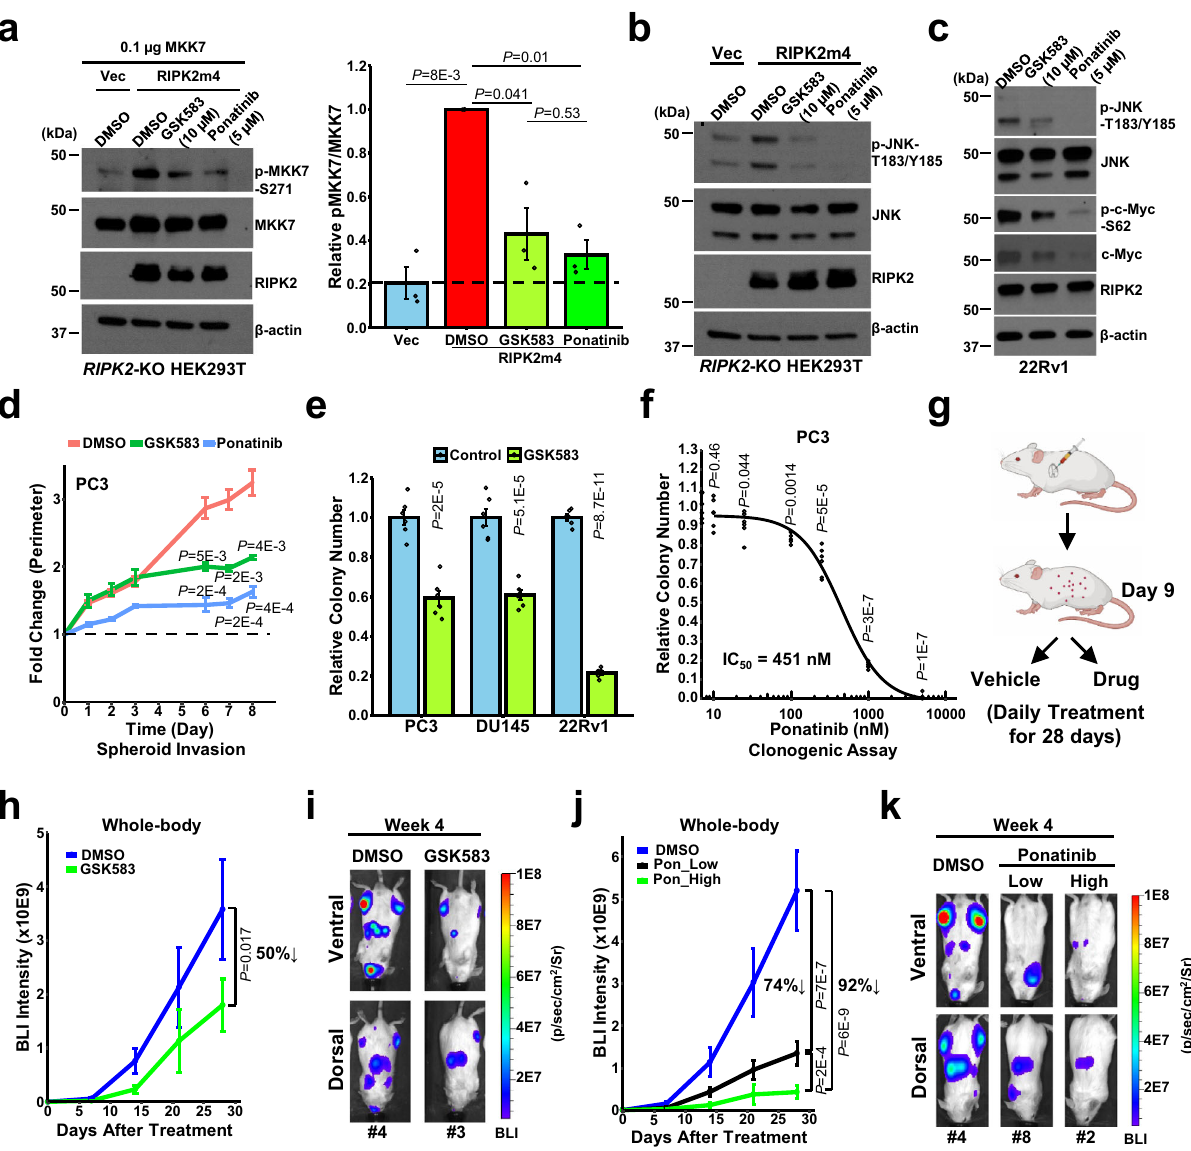
Fig. 8 Pharmacological inhibition of RIPK2 inactivates RIPK2/MKK7/c-Myc signaling and suppresses PC metastatic outgrowth. a Representative immunoblots (left) and quanti fi cation (right) of p-MKK7-S271 in total lysates of RIPK2 -KO HEK293T cells under the indicated conditions (2 h treatment in the presence of 10% FBS) ( n = 3 biologically independent samples per group). b , c Representative immunoblots of the indicated proteins in total lysates of b RIPK2 -KO HEK293T cells or c 22Rv1 cells under the indicated conditions (2 h treatment). Experiments were repeated three times independently with similar results ( b , c ). d Quanti fi cation of 3D spheroid invasion assays of PC3 cells treated with vehicle control, 10 µ M GSK583, or 5 µ M ponatinib ( n = 6 biologically independent samples per group). e Bar plot of anchorage-dependent colony formation of PC3, DU145, and 22Rv1 cells treated with vehicle control or 10 µ M GSK583 ( n = 6 biologically independent samples per group). f Drug response curve of anchorage-dependent colony formation of PC3 cells treated with vehicle control or the indicated concentrations of ponatinib ( n = 6 biologically independent samples per group). g Schematic diagram of drug treatment for the inhibition of PC metastasis in vivo. Created with BioRender.com. h Effect of GSK583 treatment (10 mg/kg/day) on total BLI intensities in biologically independent mice (vehicle, n = 5; GSK583, n = 7), starting on day 9 following the i.c. injection. i Representative BLI images of the ventral (upper) and dorsal (lower) sides of mice treated with vehicle control or GSK583 for 4 weeks. j Effect of low-dose (6 mg/kg/day) or high dose (30 mg/kg/day for 10 days followed by 15 mg/kg/day for 18 days) ponatinib treatment on total BLI intensities in biologically independent mice (vehicle, n = 6; low-dose ponatinib, n = 8; high-dose ponatinib, n = 7), starting on day 9 following the i.c. injection. Pon: ponatinib. k Representative BLI images of the ventral (upper) and dorsal (lower) sides of mice treated with vehicle control, low-dose ponatinib, or high-dose ponatinib for 4 weeks. Nominal p- values were determined by unpaired two-tailed Student ’ s t -test ( a , d – f ) or two-way ANOVA ( h , j ). Data are Mean ± SEM ( a , d – f , h , j